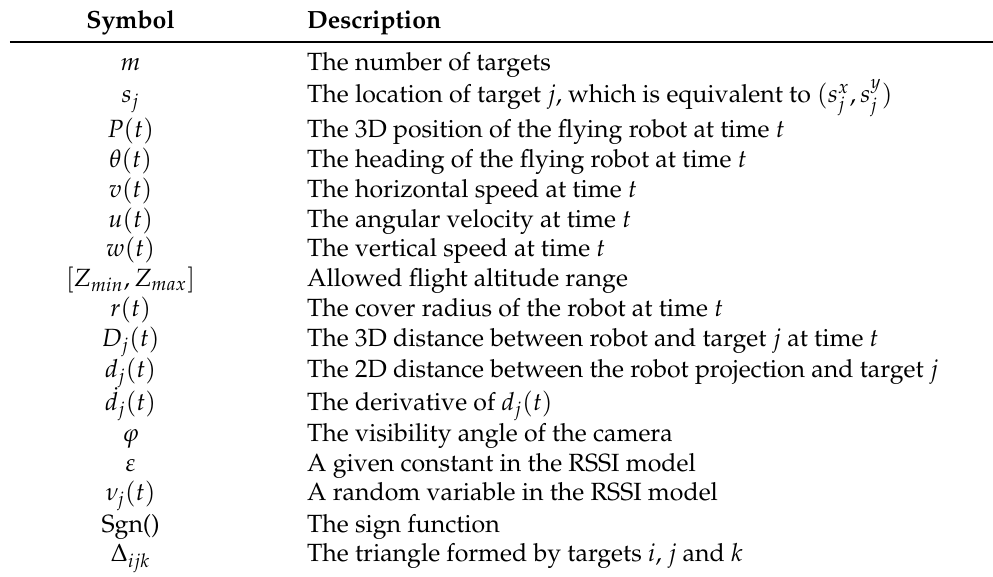
Table 1. Symbols and